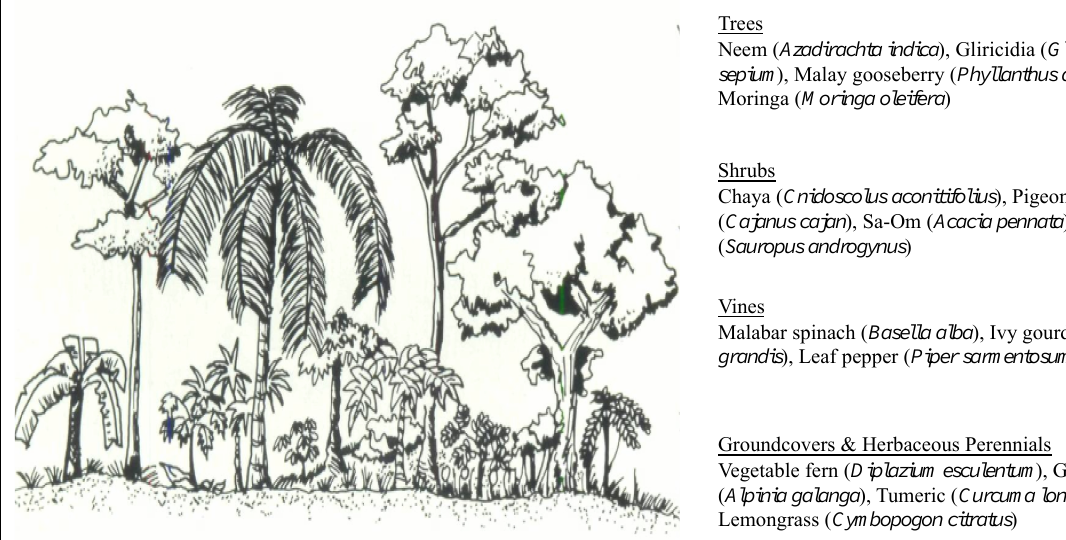
Figure 1. Optimizing Tropical Plant ‘Layers’ with Perennial NUS